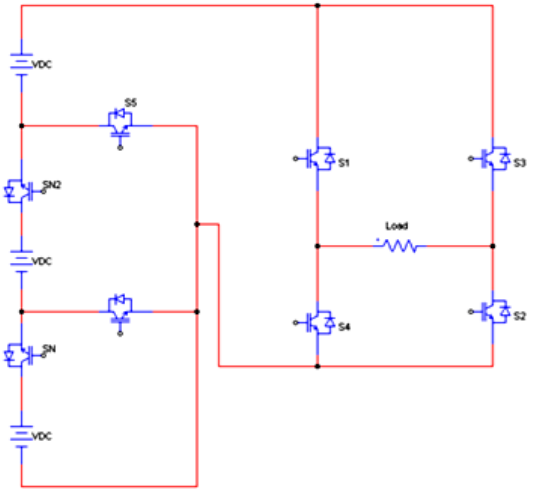
Figure 3. Circuit of 11-level inverter.